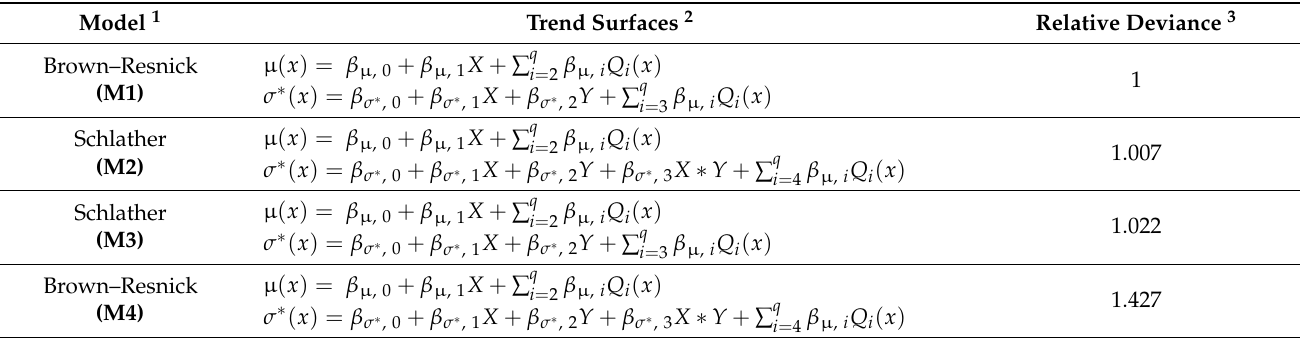
Table 2. Pairwise deviance from the four most favorable max-stable